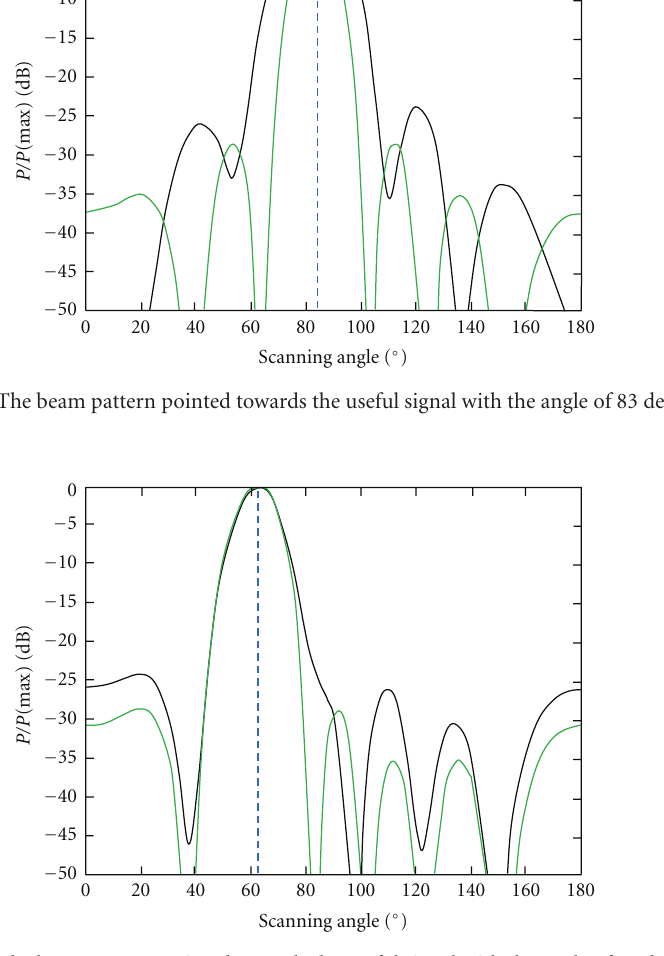
Figure 13: The beam pattern pointed towards the useful signal with the angle of 62 degrees.